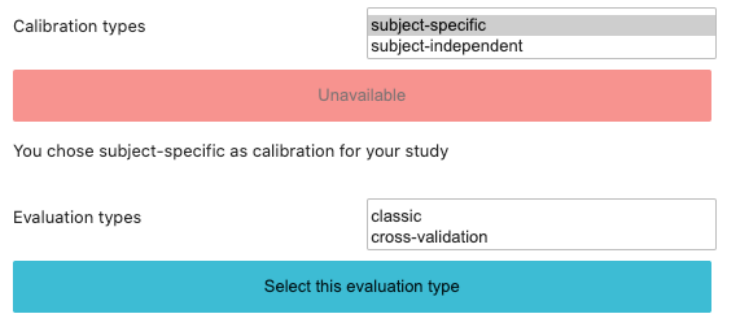
Figure 4. Screenshot of BioPyC’s choice of both calibration and evaluation